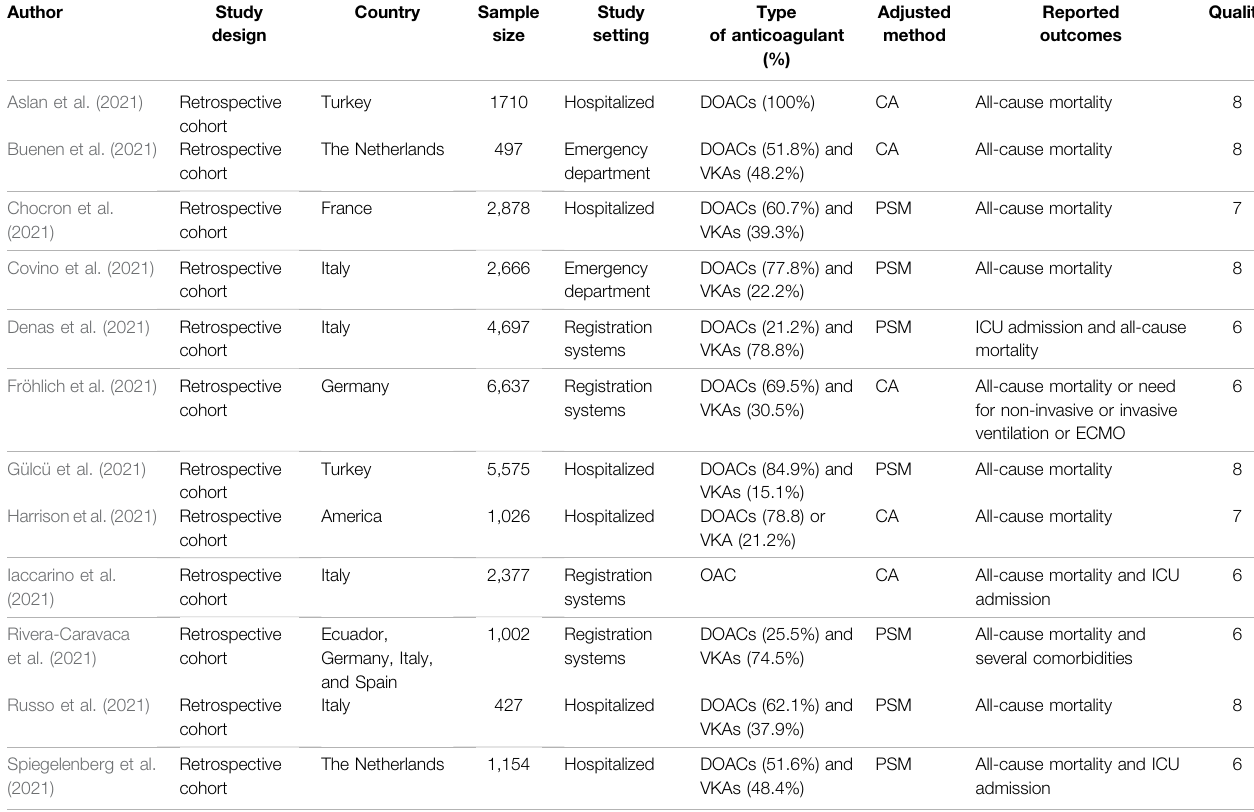
TABLE 1 | Characteristics of included trials.